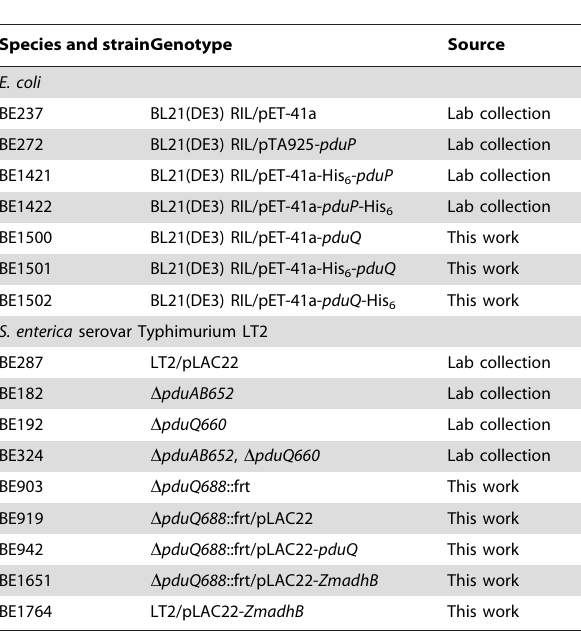
Table 1. Bacterial strains used in this